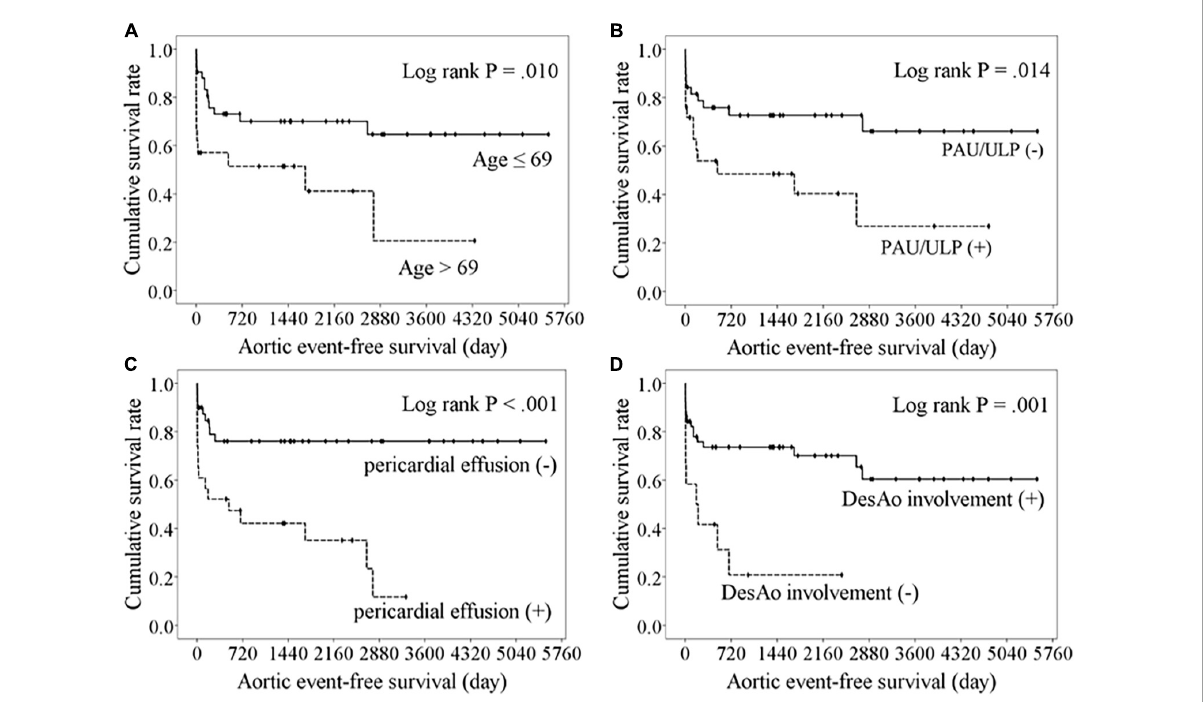
FIGURE5 Kaplan–Meier analysis of freedom from aortic events comparing with the variables. Lower aortic event-free survival were observed in patients with aged over 69 years (A) , the presence of PAU or ULP (B) , pericardial effusion (C) , or absence of descending aorta involvement (D) .